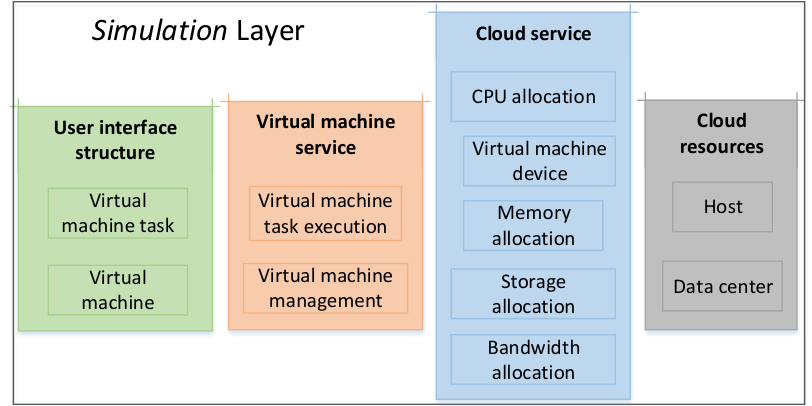
Figure 3. Structure of the Simulation layer in CloudSim.